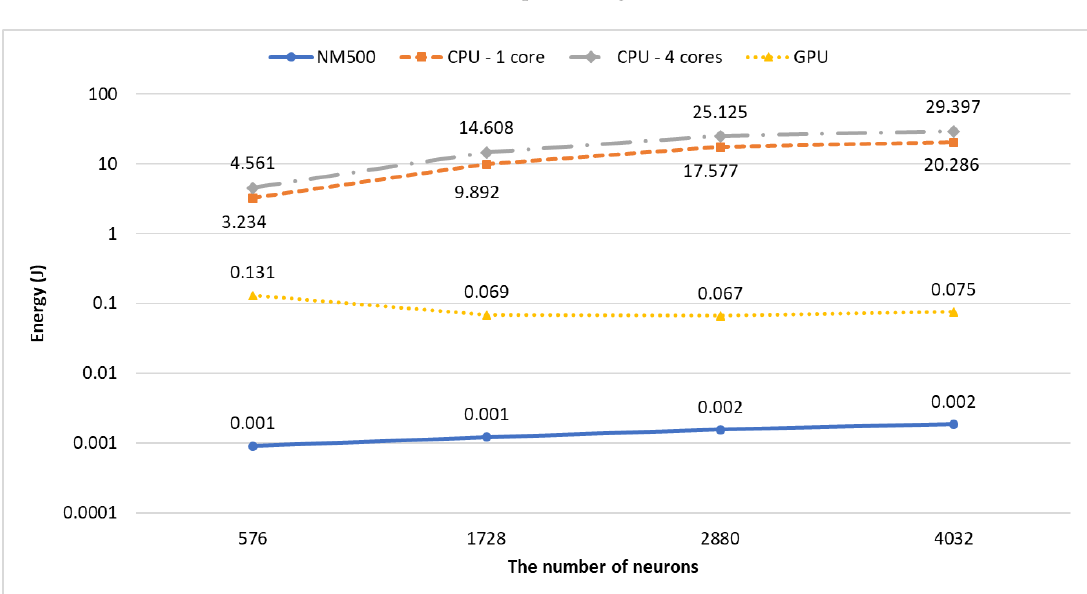
Figure 4. Time for processing all test data.